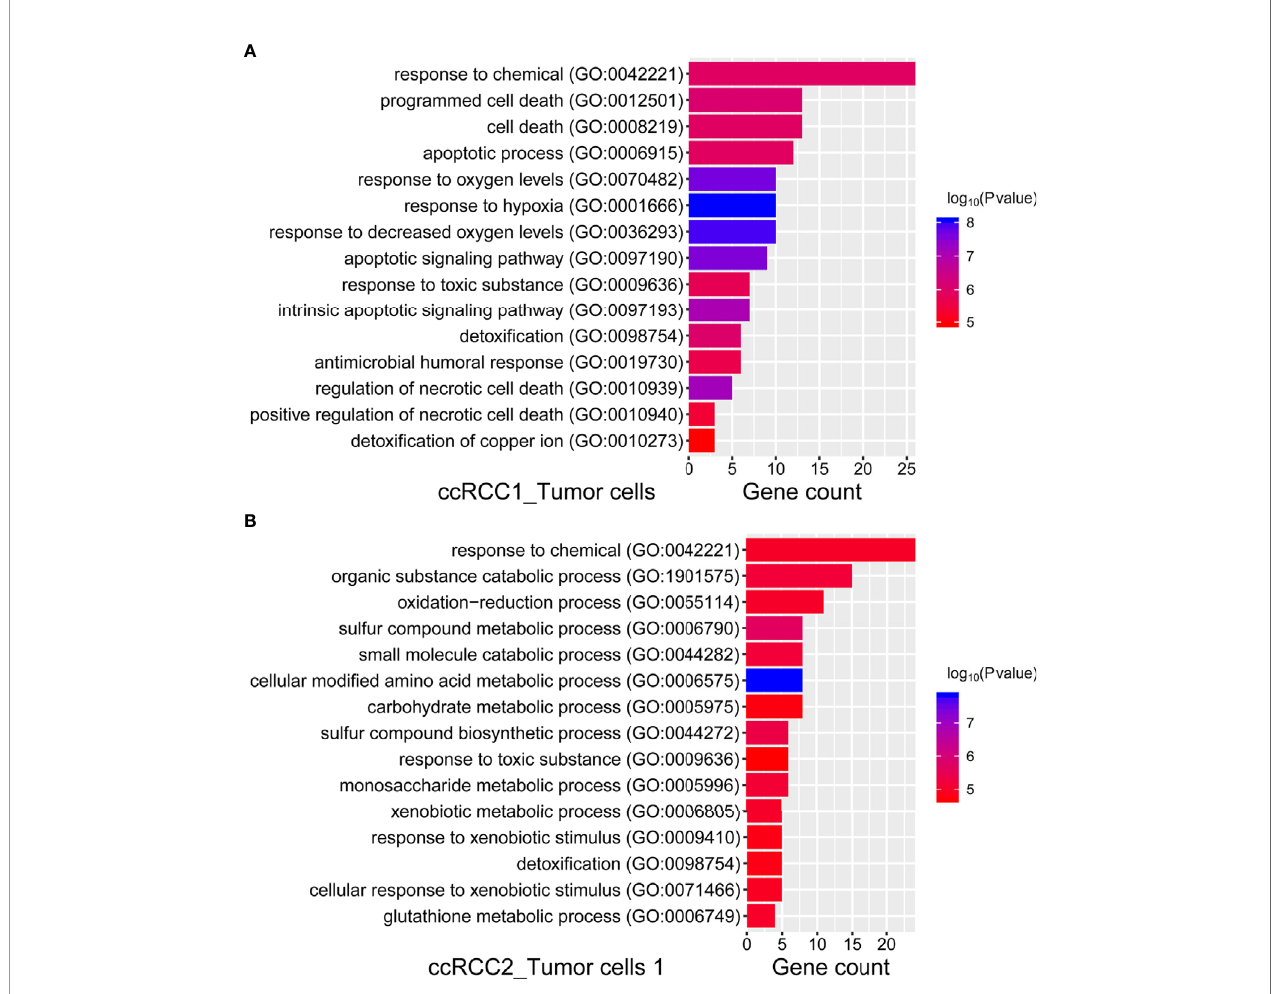
FIGURE 7 | GO enrichment analysis of ccRCC1 and ccRCC2 tumour cells for biological process. (A) We presented the most signi fi cant 15 biological processes in ccRCC1 tumor cells, according to the top 50 DEGs, which were selected for GO enrichment analysis. (B) The most signi fi cant 15 biological processes in ccRCC2 tumor cells 1, according to the top 50